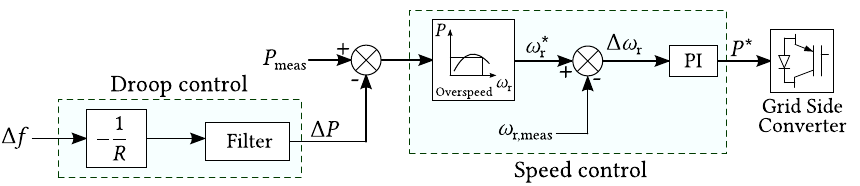
Figure 17. Droop and speed